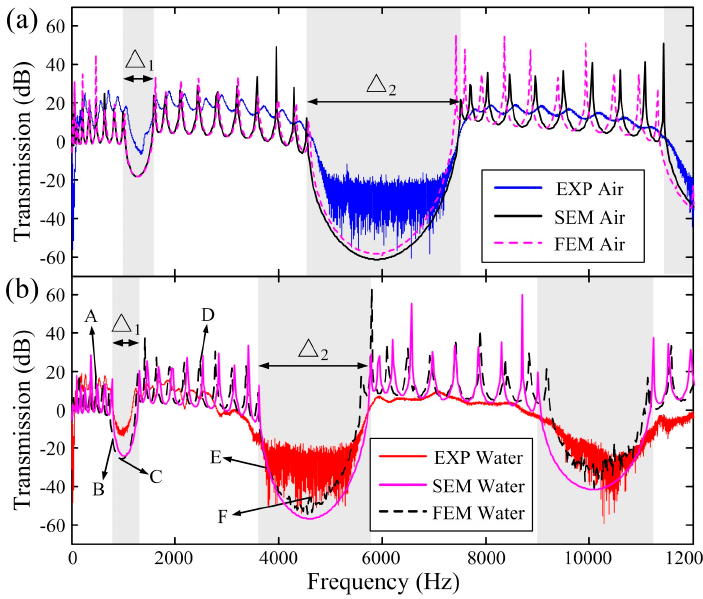
Figure 4. Displacement transmission obtained by FBG, SEM, and FEM: ( a ) in air; ( b ) in water (color online).